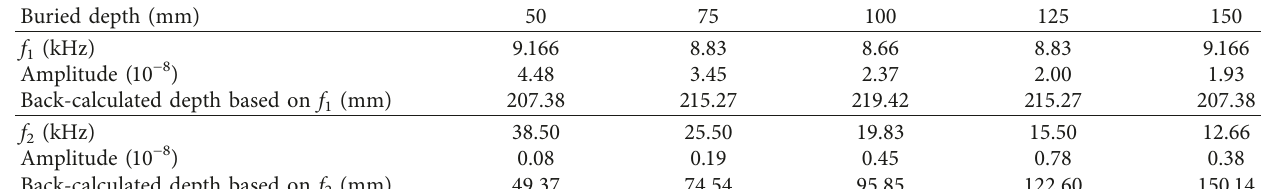
Table 4: Results of parametric analysis.